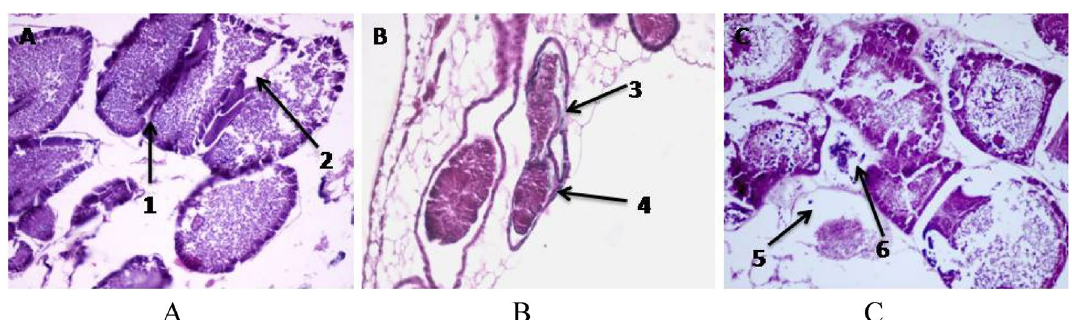
Figure 3. (A–C) Longitudinal sections in ovarioles of adult Ephestia cautella emerged from full grown pupae irradiated with ( A ) (50 Gy), ( B ) (100 Gy) and ( C ) (150 Gy) ×400. 1, Deterioration; 2, separation; 3, shrinking oocyte; 4, abnormal oocyte; 5, absence oocyte, 6, 50 Gy. Figure 3B shows that the irradiation at 100 Gy caused malformed oocytes and appeared clumped, semi- absorbed or degenerated leaving vacuoles everywhere. The dose of 150 Gy caused severe ovarian histological damages such as complete rupture of the ovariole outer sheath, the oocytes appeared abnormal and some of them looked irregular in shape with a complete absence of the nurse cells Fig. 3C. Histological structure of the male reproductive system. The male reproductive system of newly emerged Ephestia cautella is composed of two testes in a scortum which appears as a spherical white yellowish structure covered with a thin wall. Each testis consists of four testicular follicles (chambers) that open in the vasa differentia. The two vasa differentia are united together to from a common ejaculatory duct which terminates at the base of aedeagus. Examination of the transverse section of unirradiated E. cautella male showed that there are various stages of sperm development within the adult testis. Each testicular follicle consists of a germarium and the growth zone in which the spermatogonial cells (primary and secondary spermatocytes) occupy the peripheral region of the testis. The maturation zone the part were the spermatocytes transform by two meiotic divisions to spermatids that develop to spermatozoa in shape of bundles in the central area (Fig. 4). Male moths emerging from irradiated pupae at doses of 50, 100 and 150 Gy showed a clear reduction in the size of testis which seemed irregular in shape as compared to the unirradiated males. The cross sections through the testis of moths showed various degrees of damage according to dose. The testicular wall became thinner and sometimes looked ruptured. Spermatogonia looked based on irregular surface. A clear separation or detachment of spermatogonia with an absence of some cells was observed. The interfollicular partition appeared broken. Some spermatocytes appeared in clusters and cannot be distinguished. Degeneration appeared all over the testis as dark colored masses. Sperm bundles were damaged or completely absent in many areas as large vacuoles appeared. Appearance of vacuoles in the stages of spermatogensis indicated an interruption of normal cell development in comparison to control (Fig. 5A–C). Histological section of irradiated female ovariole showed different injury compared with that of the unir- radiated female ovarioles. A dose of 150 Gy indused severe damages represented by thinness in the follicular epithelium and separation from developing oocytes when compared to those damages induced by 50 and 100 Gy. Moreover, the nurse cells sometimes, disappeared as compared with unirradiated female. The resulting malfor- mation in the female reproductive organs and tissues are in harmony with those obtained by Hassaballa et al . 10 on Ephestia kuehniella and Boshra & El-Naggar 11 on Plodia interpunctella . The reduction of oocytes in ovaries,